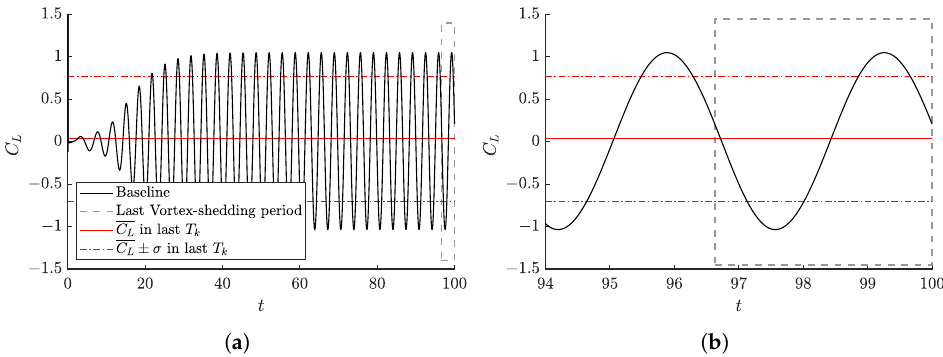
Figure 5. Temporal evolution of the lift coefficient in the baseline case (without jet actuation). ( a ) Baseline lift-coefficient results. The vortex-shedding period is 3.37 time units. ( b ) Zoom-in view of the vortex-shedding period in the baseline case.